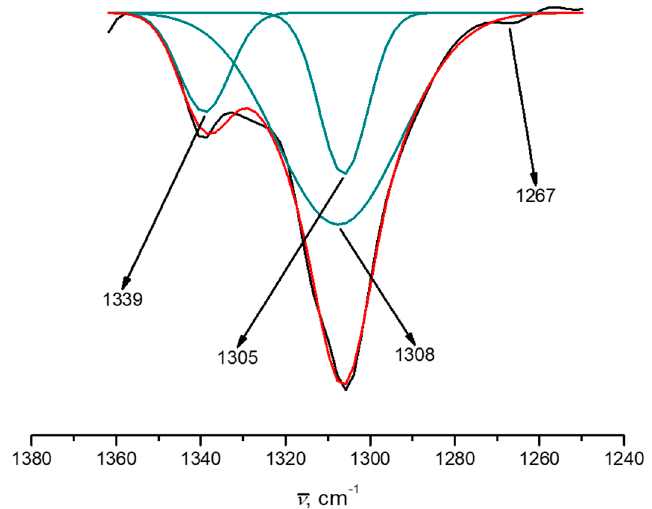
Table 4. Values of vibrations of C–O Ph groups coordinated to manganese ions obtained experimentally (Exp) and DFT estimations from models 1 - 6 . Values in cm − 1 .